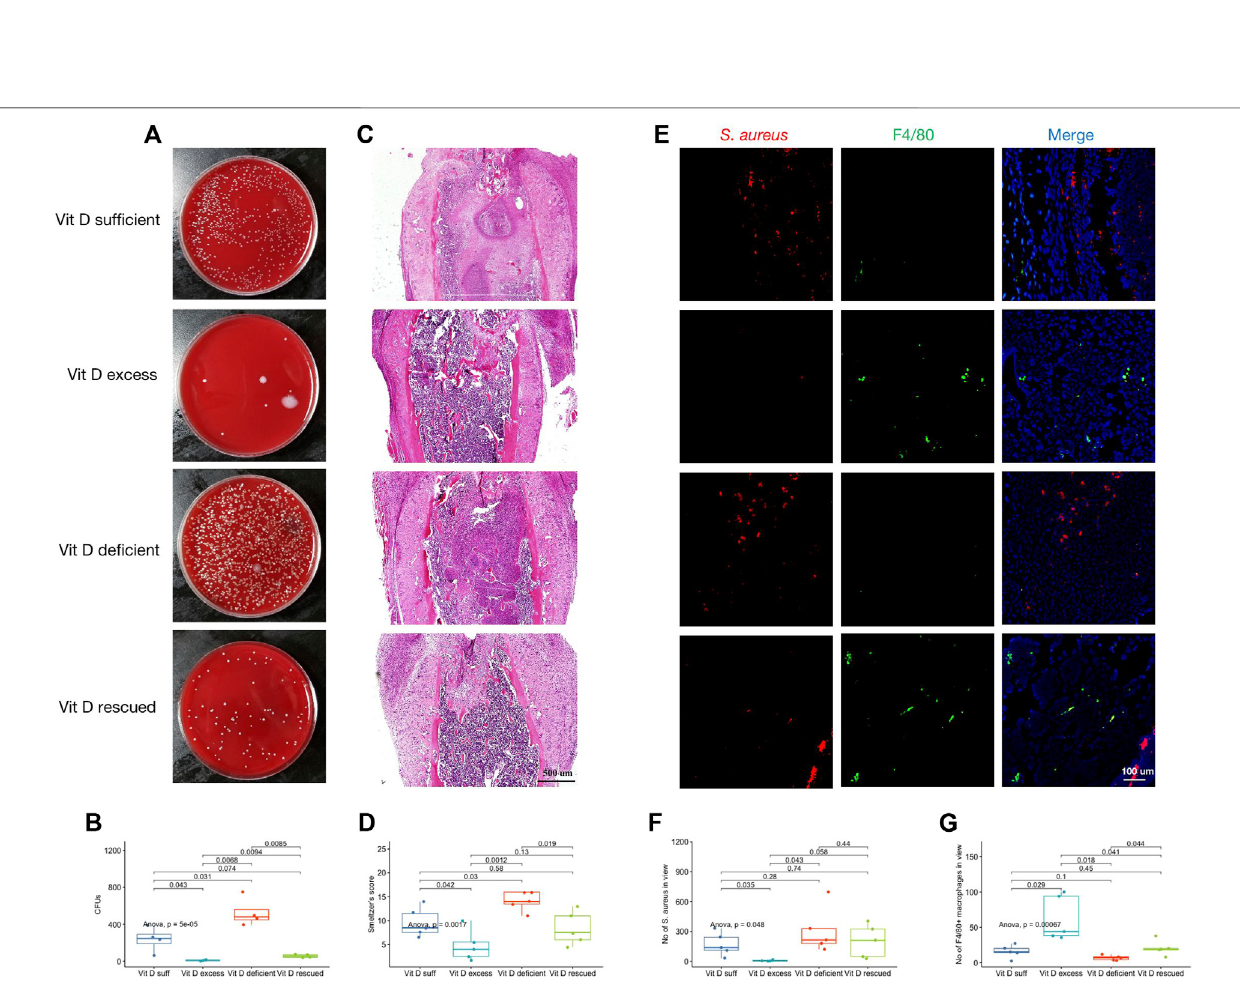
FIGURE2| VitaminDsupplementationinhibitedtherisksofIAIoccurrenceandseverity. (A) Afterthefemoralimplantwasremoved,theinfectedfemurwasground and made into a homogenized solution. Representative images after coating the plate with the homogenized solution overnight. (B) CFUs of homogenized solution in each group. (C) Representative images of H&E staining. Magni fi cation, ×40. (D) Smeltzer ’ s score. Mean value of two experienced reviewers ’ scores. (E) Double immuno fl uorescence staining for S. aureus (red) and F4/80 + macrophages (green). Magni fi cation, ×200. (F) Count of S. aureus in view. (G) Count of F4/80 + macrophages in